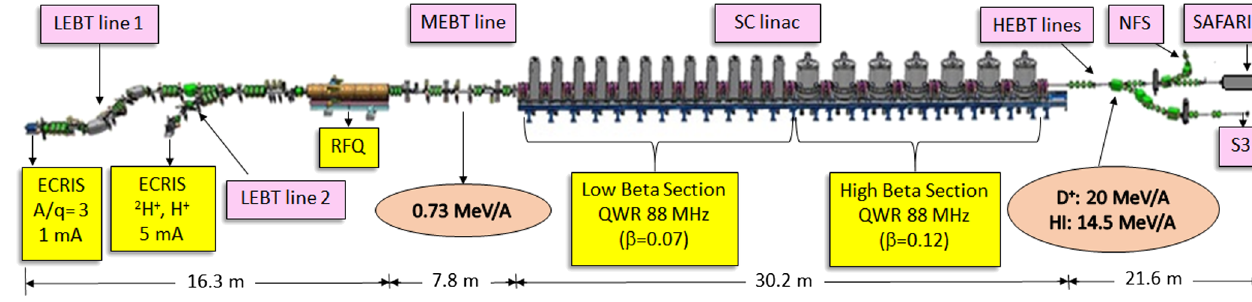
FIG. 1. SPIRAL2 SC linac layout.